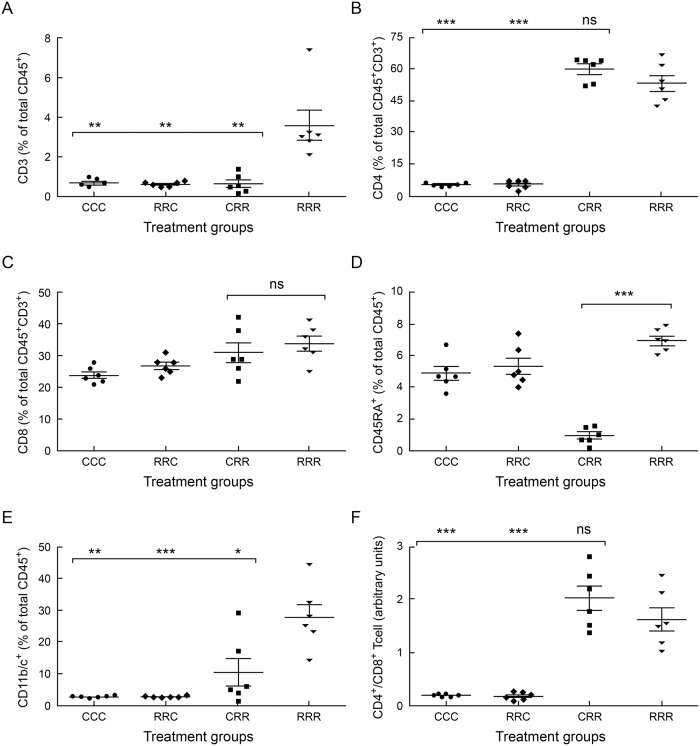
Elevated CD3+CD4negCD8neg T cells persist during recurrent early-life rrRSV LRTI.Cells isolated from BAL of 28-day old weanling rats at the peak of rrRSV LRTI were profiled using flow cytometry to quantify populations of: (A) CD3+, (B) CD4+, and (C) CD8+ T cells, as well as (D) B cells and (E) monocyte lineage cells. (F) The mean CD4+/CD8+ T cell ratio is shown for each treatment group. Data for 3 experiments were combined and expressed as the mean ± SEM of 6 rats per group. Data are expressed as percentage of total CD45+ cells or total CD45+/CD3+ cells. Two-tailed student’s t test: *P<0.05, **P<0.01, ***P<0.001 compared to the RRR group.